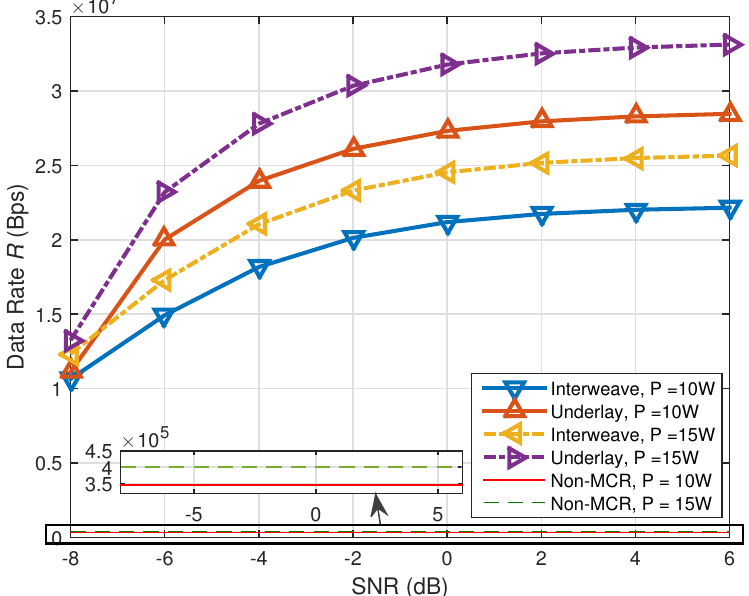
Figure 6. Received SNR versus data rate of the proposed methods in multiband-CR-enabled